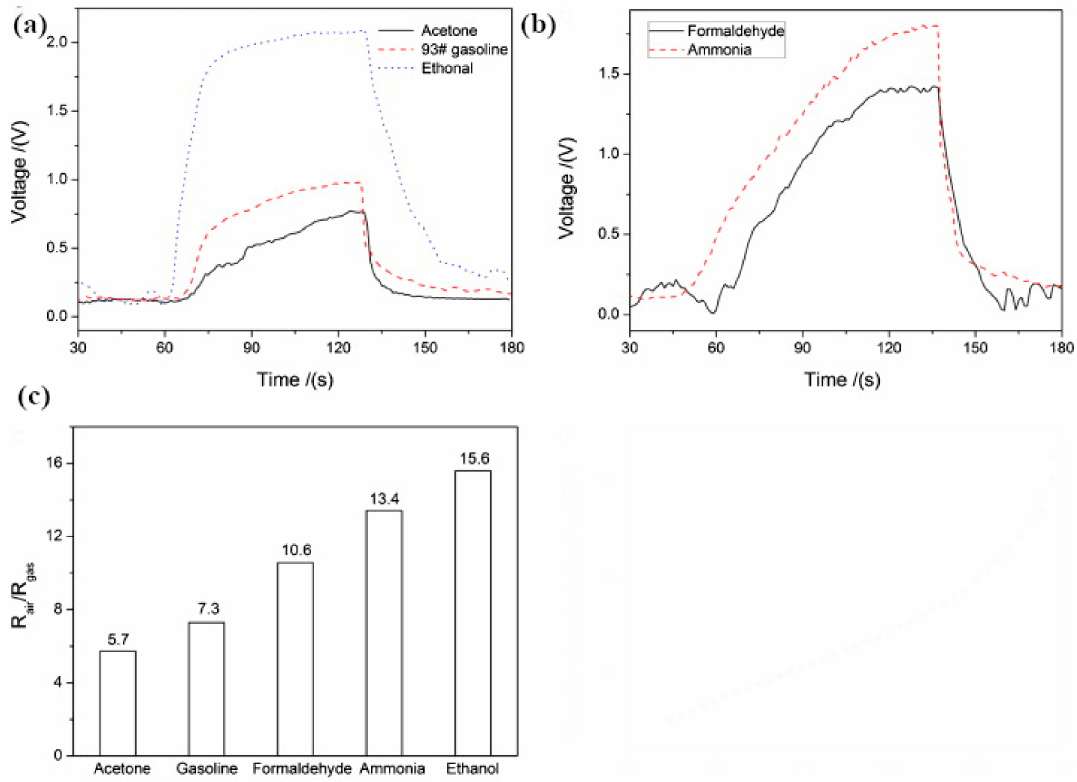
Figure 31. Sensor response of WO 3 monohydrate nanosheets: ( a , b ) Response curves of the sensor to flammable organic vapors and pure gases; ( c ) Sensor sensitivity under various gases. Reprinted from Ref. [238] with permission of Materials Chemistry and Physics,